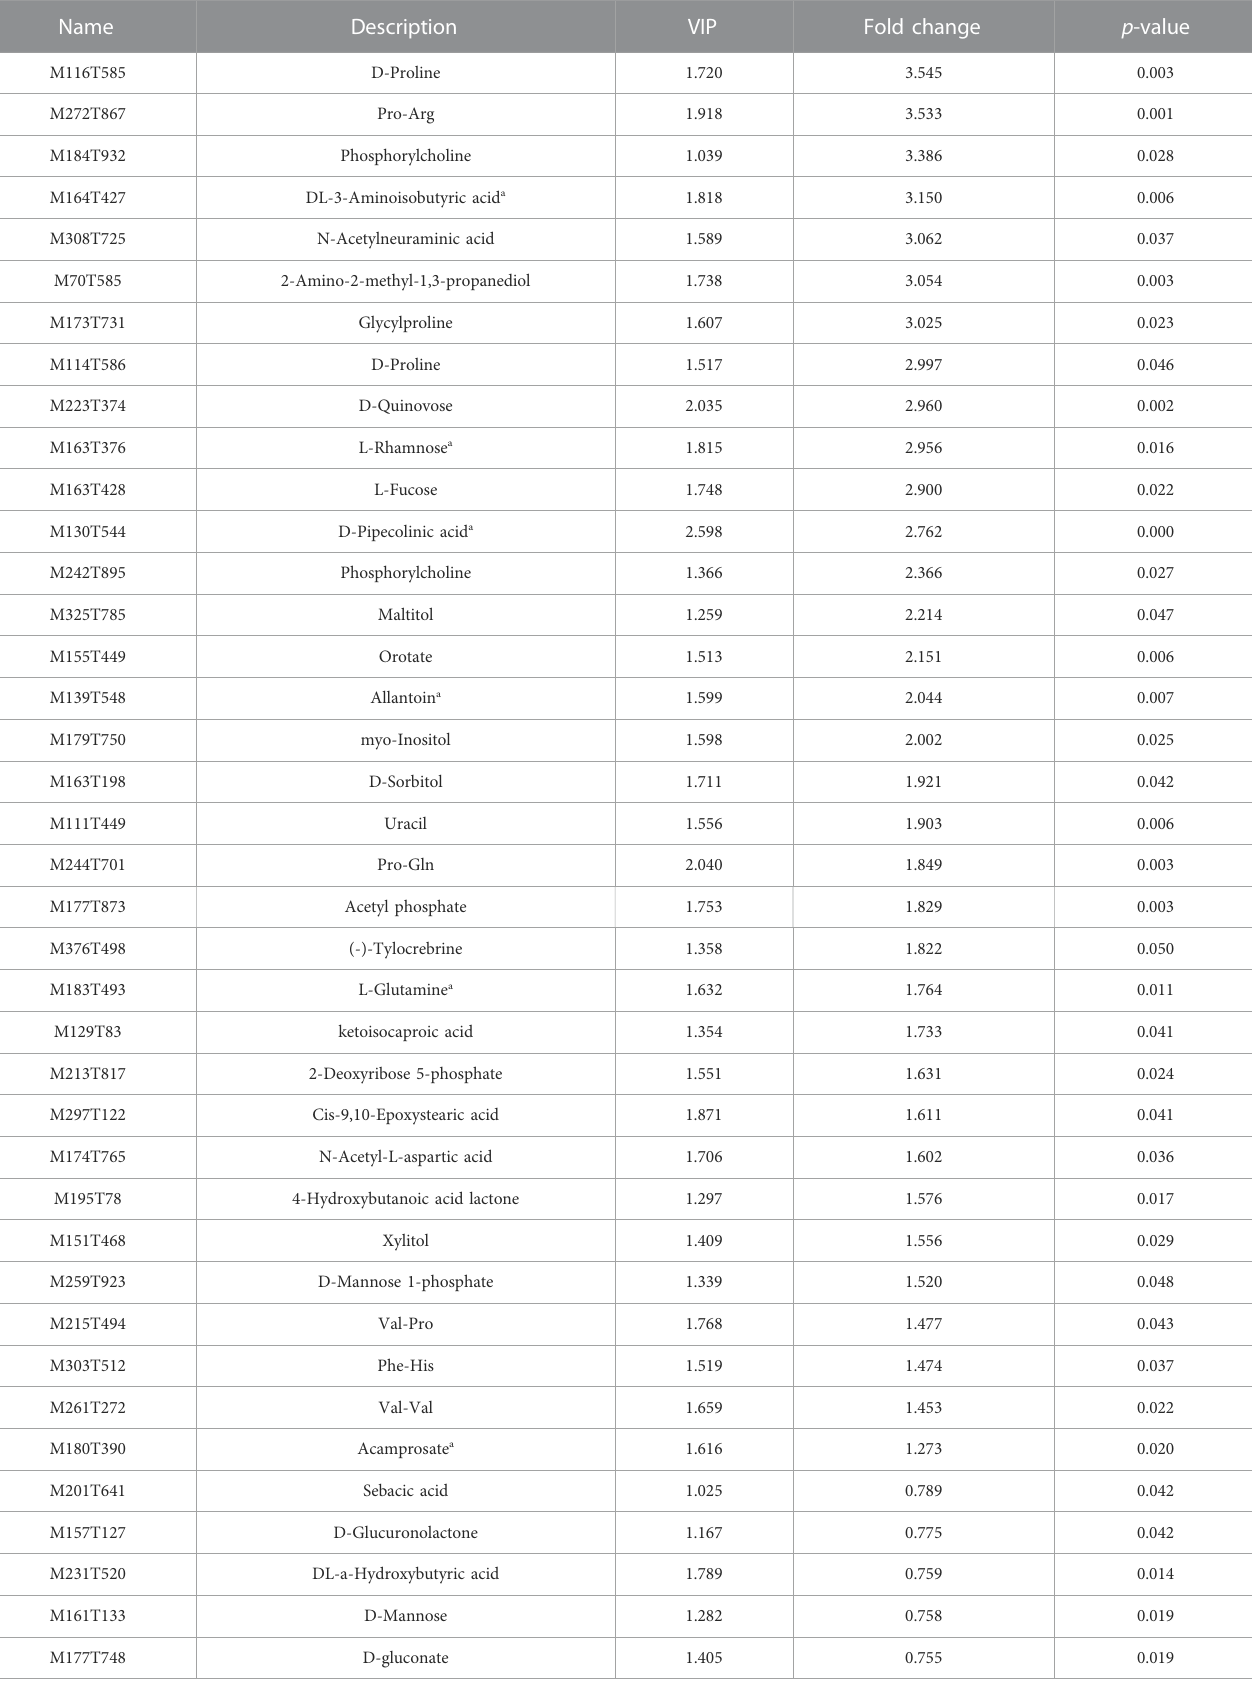
TABLE 6 Signi fi cant alterations in saliva metabolites of HD-CD.